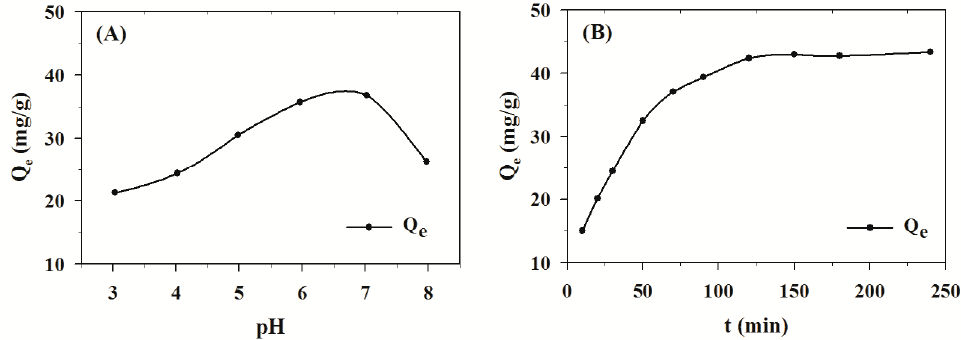
Figure 1. Effect of pH ( A ) and time ( B ) on the adsorption of tea polyphenols (TPS) by microporous starch (MPS) (MPS dose = 1.0 g/50 mL, Temp. = 293 K).